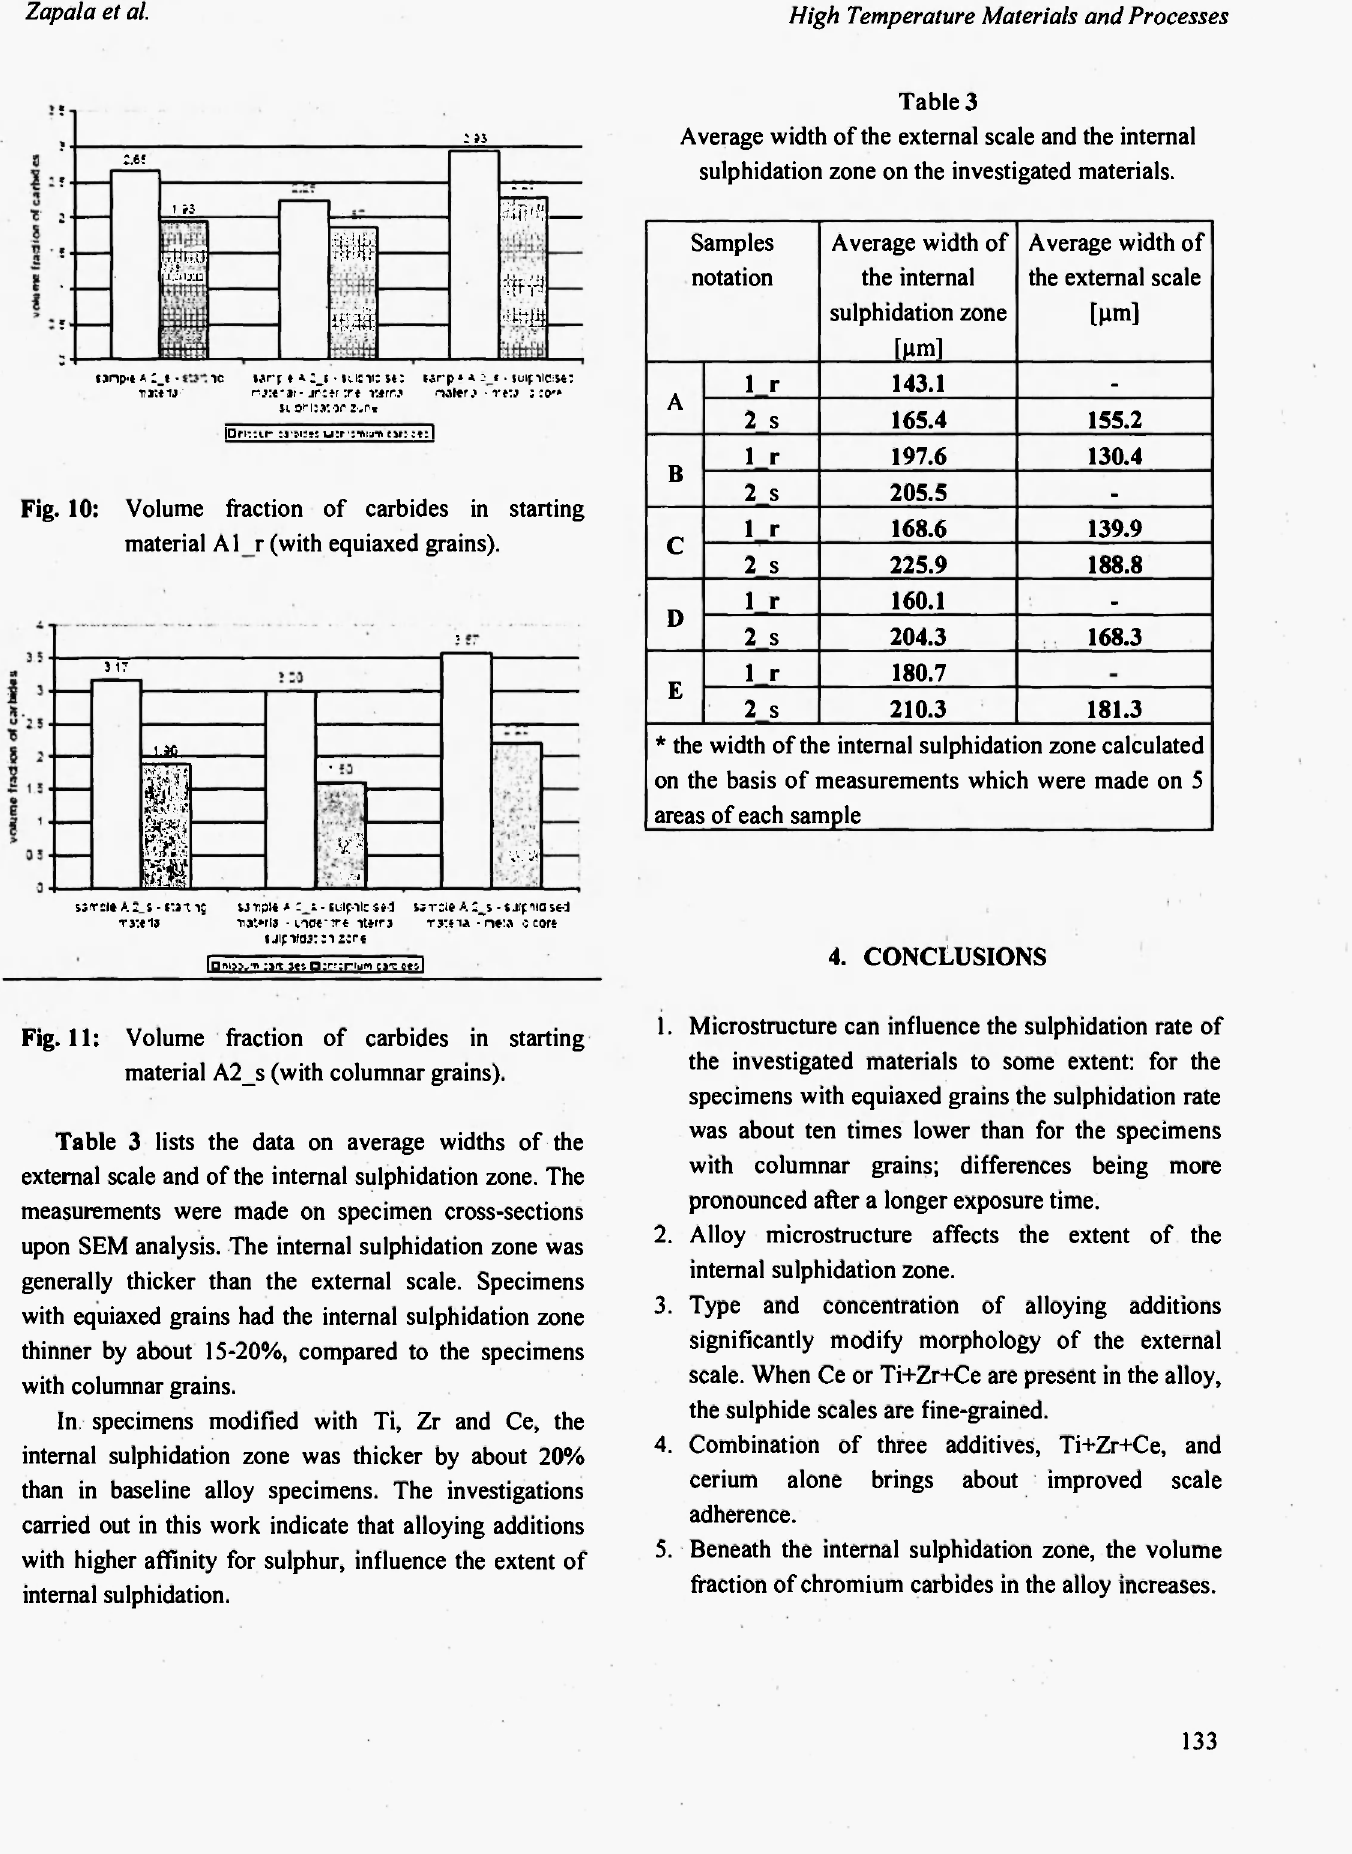
Average width of the external scale and the internal sulphidation zone on the investigated materials.